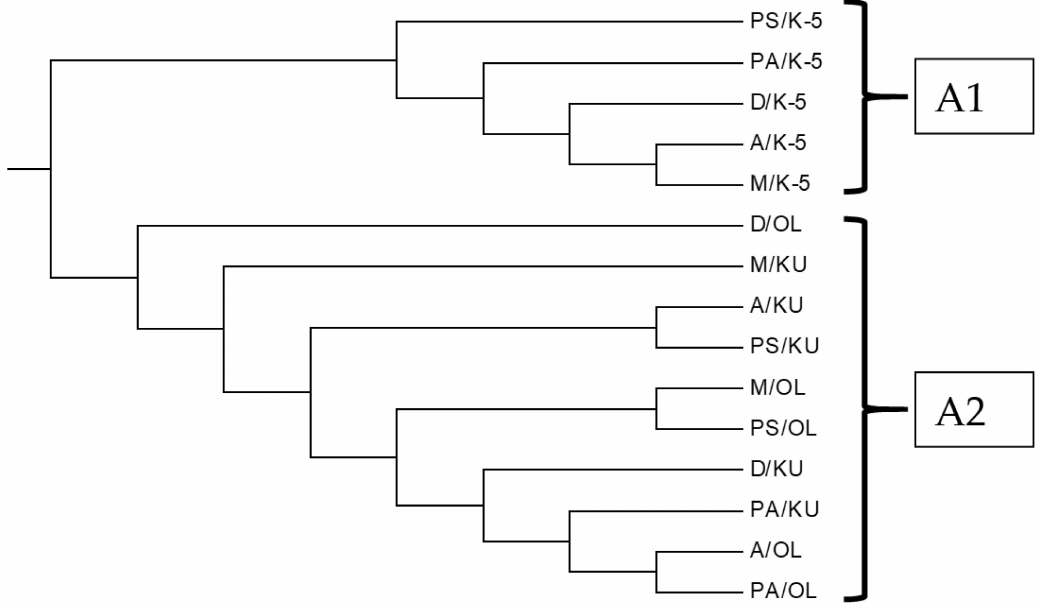
Figure 5. Genetic tree of five mango varieties grafted on three polyembryonic rootstocks using